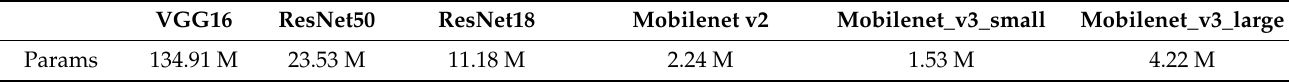
Table 3. Comparison of network